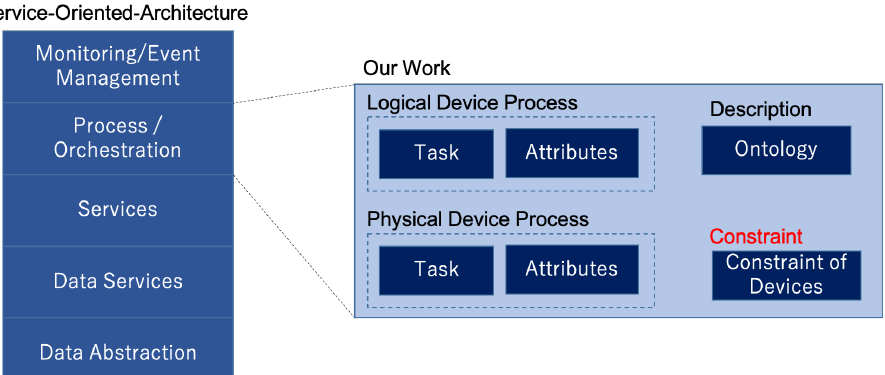
Figure 2. Overview of the positioning of our